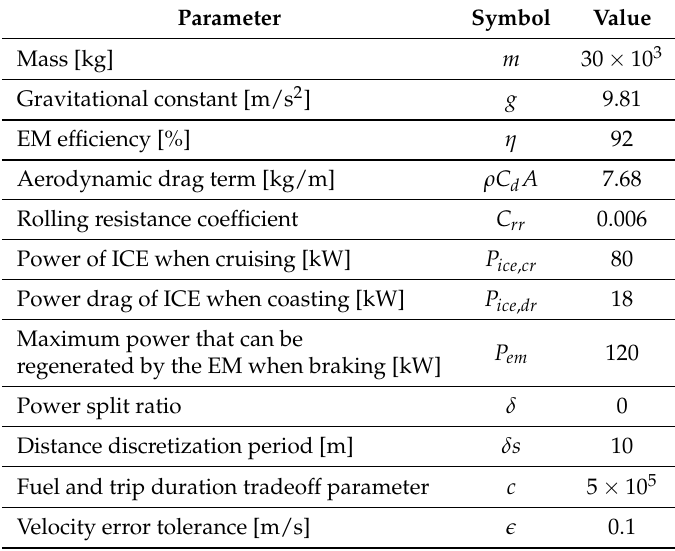
Table 2. Parameters used for the truck model and the